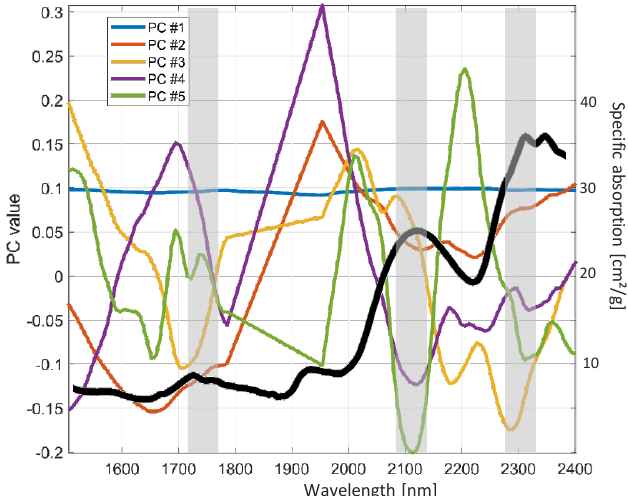
Figure 5. Principal component values (PC#1 to PC#5) as a function of wavelength, calculated from the simulated training data set. Specific absorption of CBC is given as a black line, and main absorption features of lignin and cellulose are indicated as grey